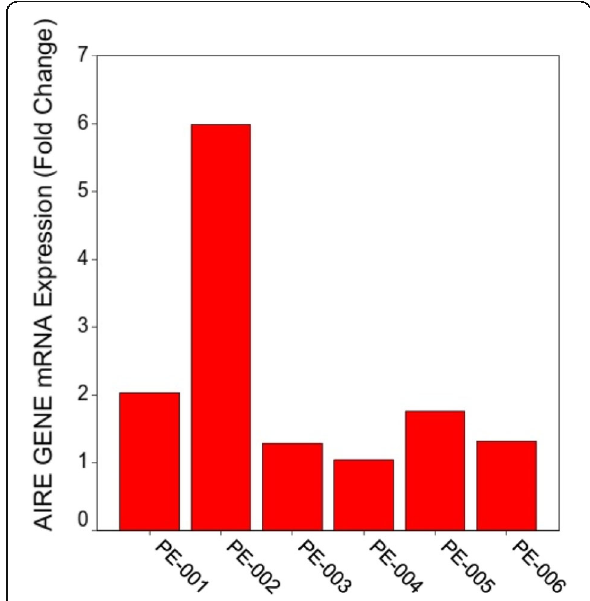
Fig. 3 Expression levels of AIRE gene mRNA: PE-002 column belongs to the case with homozygous mutation in intron 9 (c.1095 + 2 T > A); PE-001 and PE-005 represent the expression levels in patient ’ s parents with heterozygous mutation in intron 9 (c.1095 + 2 T > A); other columns show the expression level of AIRE in siblings (mutations were not